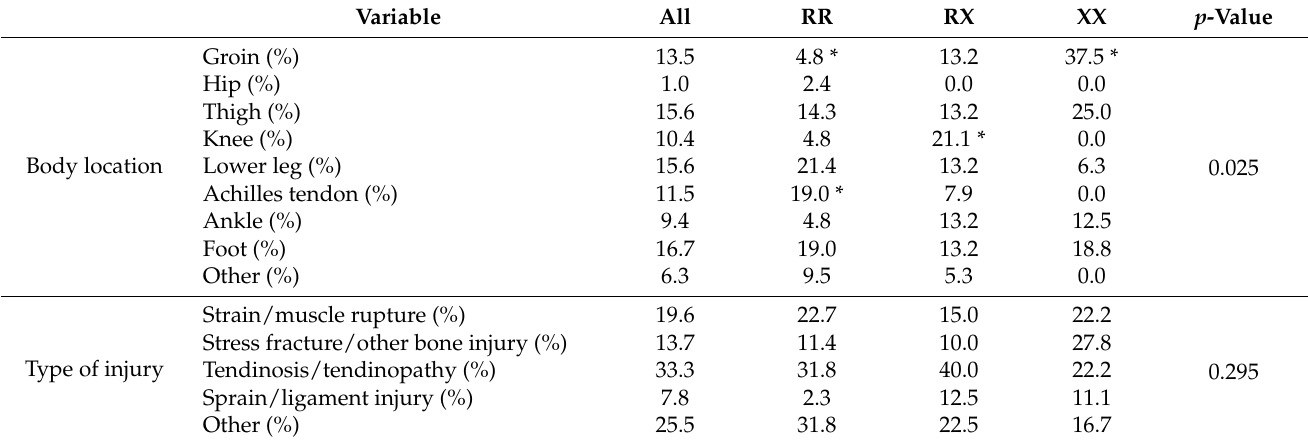
Table 4. Distribution of injuries according to body location and type of injury in elite endurance runners with different ACTN3 R577X